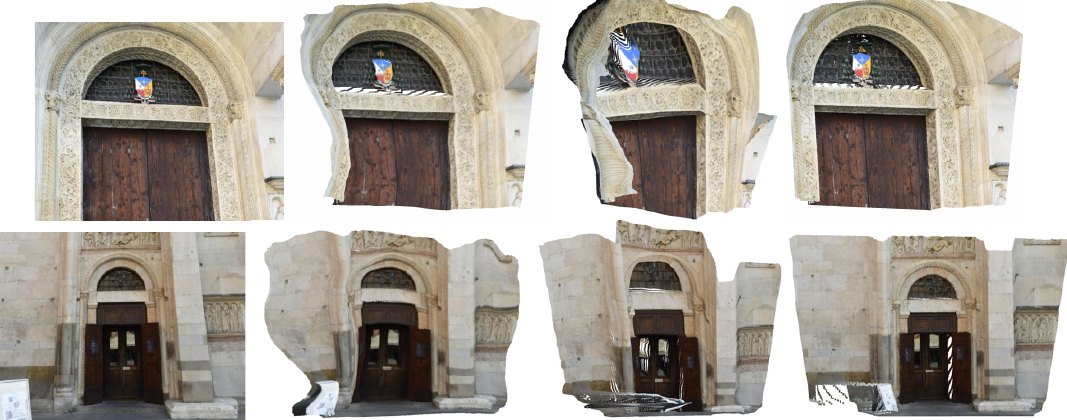
Figure 7. Experiment 2. (a) RGB input image (b) reconstructed point cloud (c) LeRes point cloud (d) GT point cloud.